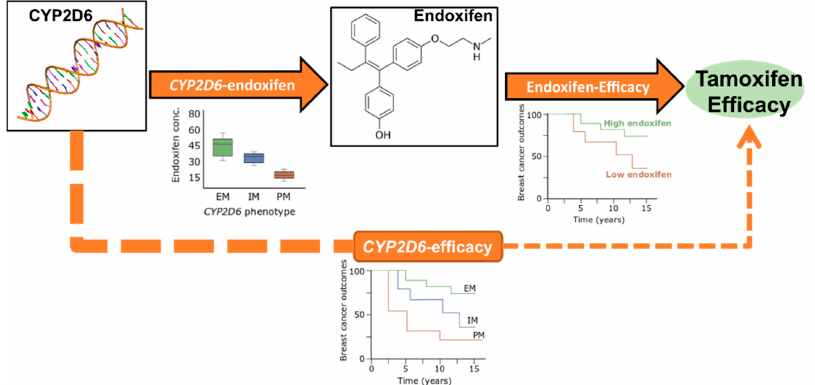
Figure 1. Approaches for investigating metabolic resistance in breast cancer patients. The CYP2D6 -endoxifen relationship is well established. The endoxifen-efficacy relationship has been reported but not sufficiently validated due to a lack of available data. The CYP2D6 -efficacy relationship has not been conclusively demonstrated due to the imprecision in using CYP2D6 as a surrogate of endoxifen concentration. Box plot and survival curves are for illustration purposes only. EM = Extensive Metabolizer, IM = Intermediate Metabolizer, PM = Poor Metabolizer.